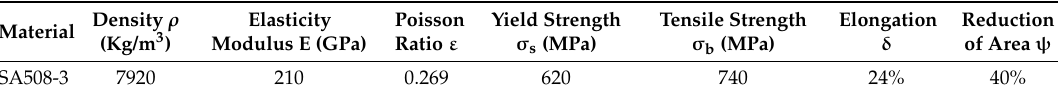
Figure 3. ( a ) Experimental platform and ( b ) staggered teeth BTA drill. Table 1. Physical characteristic parameters of SA508-3